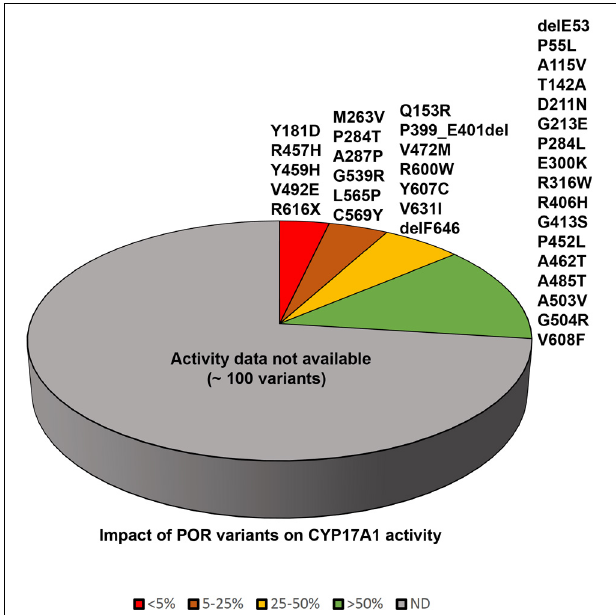
FIGURE 5 | Impact of POR variants on CYP17A1 activity. A pie chart showing the impact of POR variants on CYP17A1 17,20 lyase activity. The variants which had < 5% of WT activity are grouped as red, variants with 5–25% of WT activity are in orange, variants with 25–50% of activity are in yellow, and variants with > 50% activity are in green. A large number of recently identified variants from large scale sequencing studies have not been tested in enzymatic assays and these are grouped in gray color